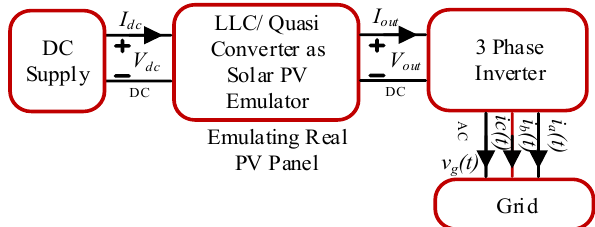
Fig. 1 PV emulator connection to a grid connected 3 phase